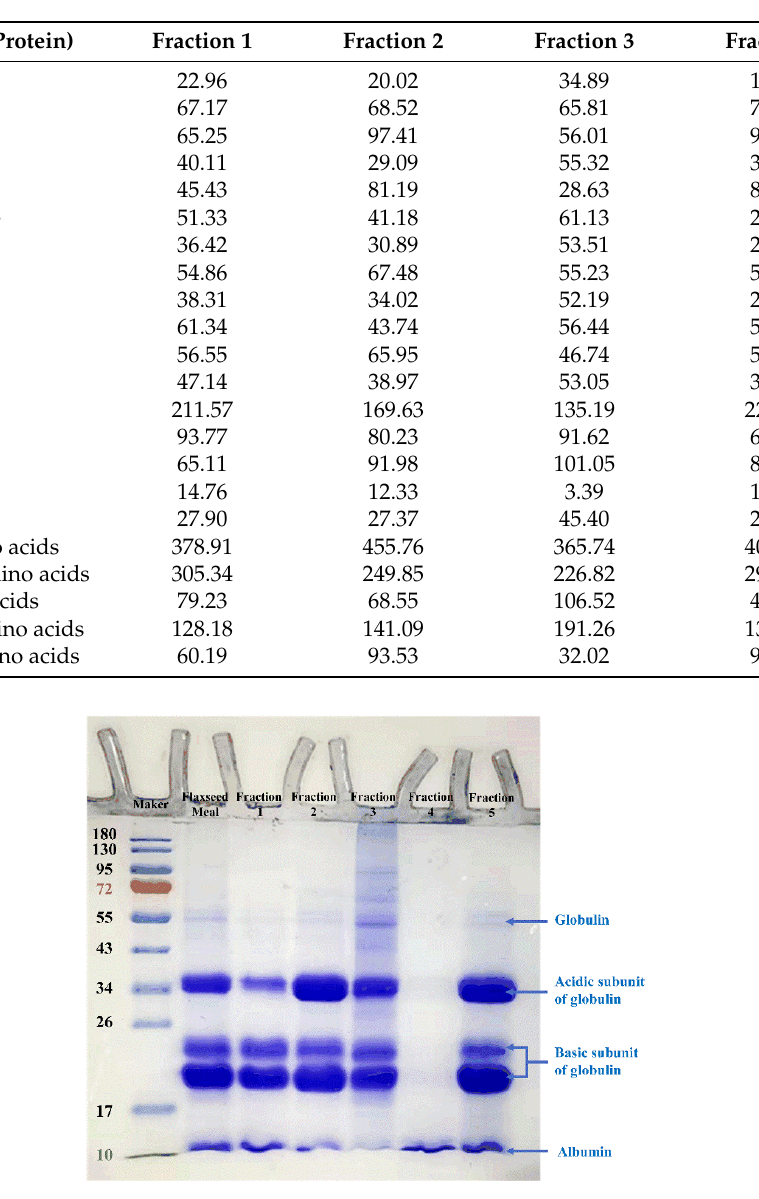
Table 2. Amino acids composition (mg/g protein) after hydrolysis of flaxseed protein-polysaccharide natural fractions.